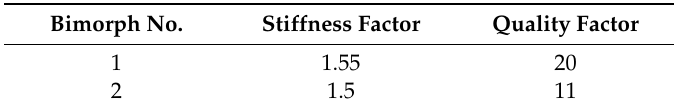
Table 6. Two bimorphs system—stiffness and Q factors.